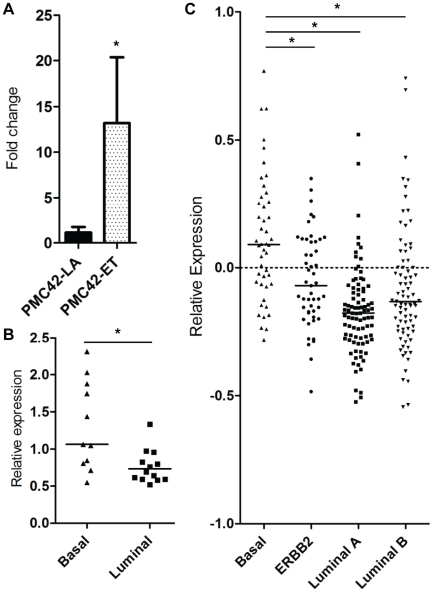
Expression of P2X5 in breast cancer cell lines and clinical samples.A, quantitation of P2X5 mRNA in PMC42-ET (mesenchymal) breast cancer cells relative to PMC42-LA (epithelial-like) breast cancer cells; * P<0.05, unpaired t-test. B, Relative P2X5 expression was examined using microarray data from 24 human breast cancer cell lines classified as luminal or basal via transcriptional profiling. A Mann-Whitney test was used for assessing statistical significance (*P<0.05). C, Evaluation of P2X5 levels in 264 human breast cancer samples representing four transcriptional subtypes. Statistical analysis was performed using Kruskall-Wallis test with Dunn's post-test and * signifies P<0.05. Horizontal lines represent the median value for each cluster.